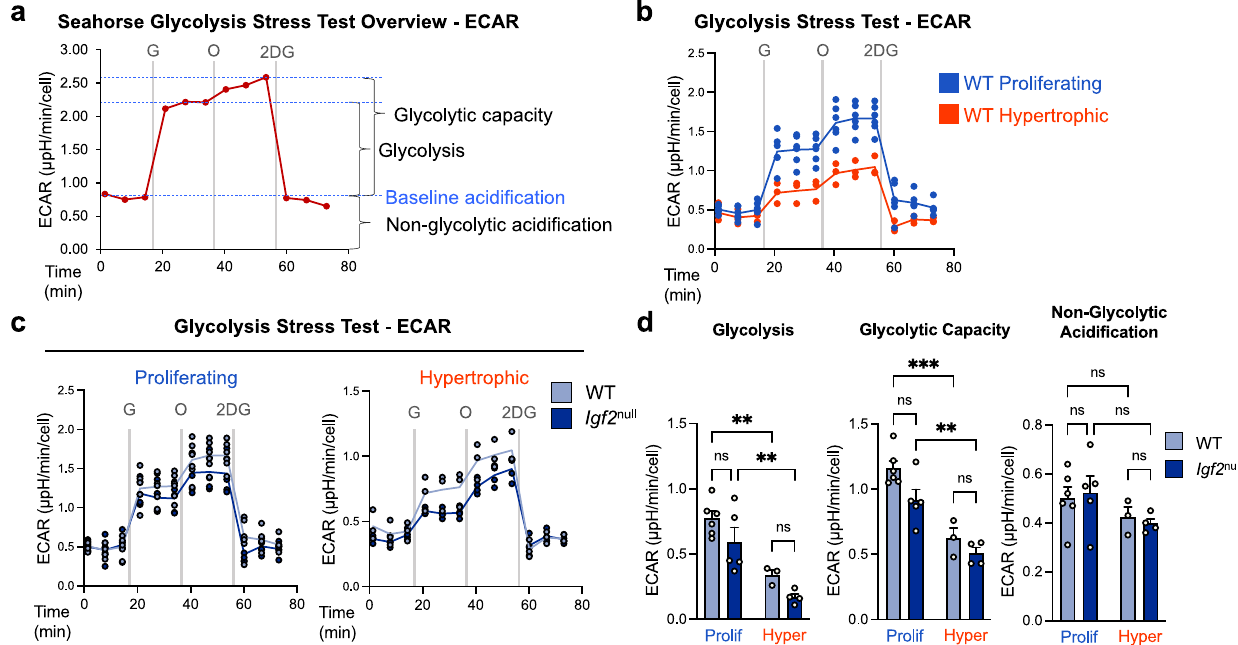
Fig. 3 Hypertrophy is characterized by a decrease in glycolysis and glycolytic capacity. a Schematic of expected extracellular acidi fi cation rate (ECAR) readings for a Glycolysis Stress Test in the Seahorse XFe96 metabolic analyzer, including injection points for glucose (G), oligomycin (O), and 2-deoxyglucose (2DG). b Metabolic analysis (ECAR) of WT epiphyseal chondrocytes under proliferative and hypertrophic conditions. c Metabolic analysis of WT and Igf2 null epiphyseal chondrocytes under proliferative and hypertrophic conditions. Note that the WT lines in ( c ) are the same as in ( b ). d Glycolysis, glycolytic capacity, and non-glycolytic acidi fi cation as calculated from ECAR measurements. Data are presented as individual measurements with a line indicating the mean ( b , c ) or individual measurements with mean + SEM ( d ), representative of n = 4 experiments with 3 – 6 wells per group. Statistical signi fi cance was calculated using a two-way ANOVA with Tukey ’ s test for multiple comparisons ( d ). p -values indicated as ns (not signi fi cant), * p < 0.05, ** p < 0.01, *** p <